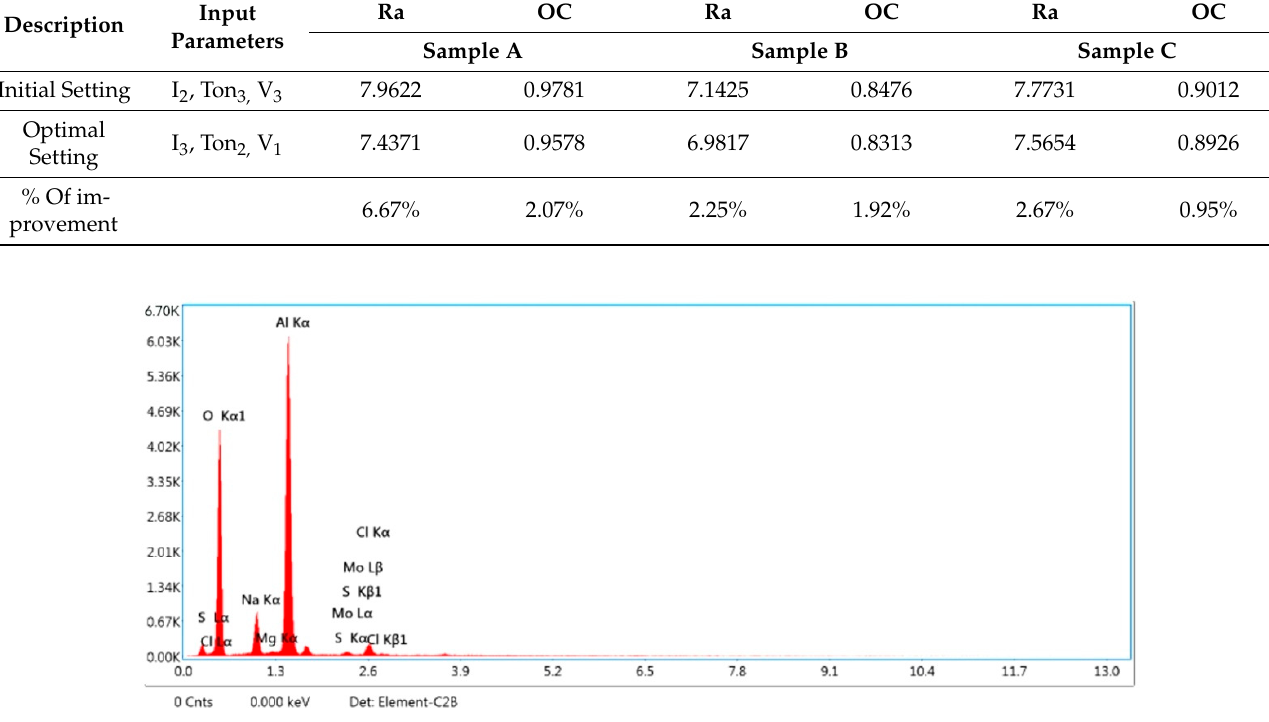
Figure3 EDX image of machined surface initial conditions. Figure 3. EDX image of machined surface initial